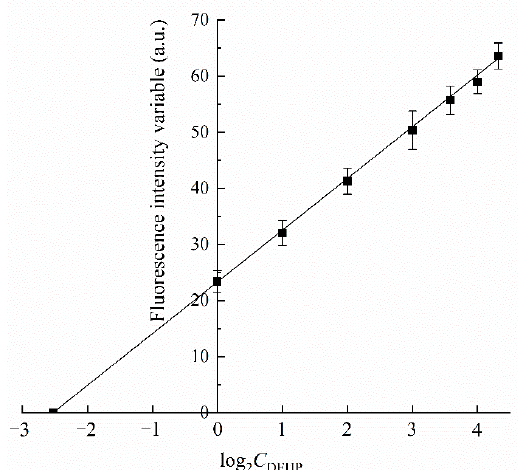
Figure 5. Detection of DEHP in aquatic wastewater samples. A total of 10 µL of wastewater samples containing 1, 2, 4, 8, 12, 16, and 20 µg/L DEHP were analyzed, and the fluorescence variable curves of the fluorescence signal were linearly correlated with the concentration of DEHP (base number of Log 2).